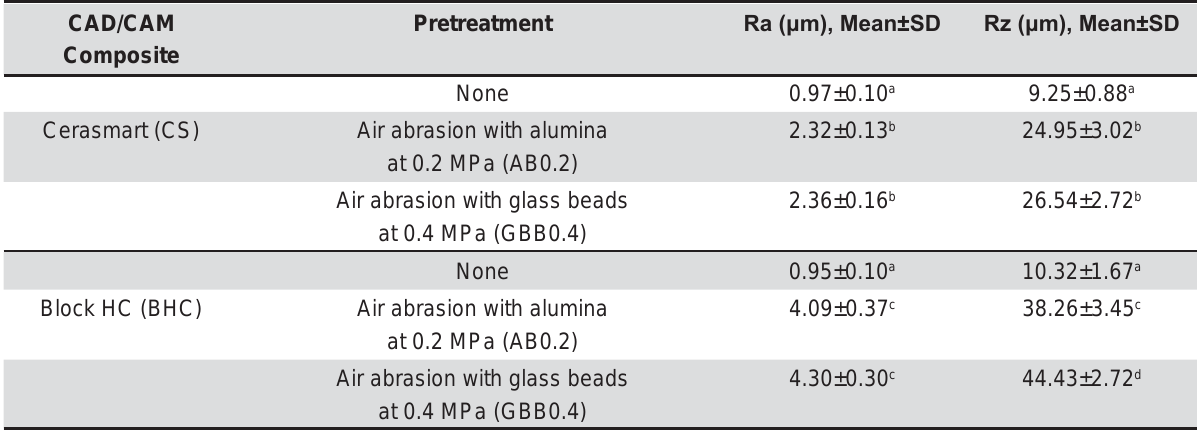
Table 1- Surface roughness of two CAD/CAM composite materials after different pretreatments